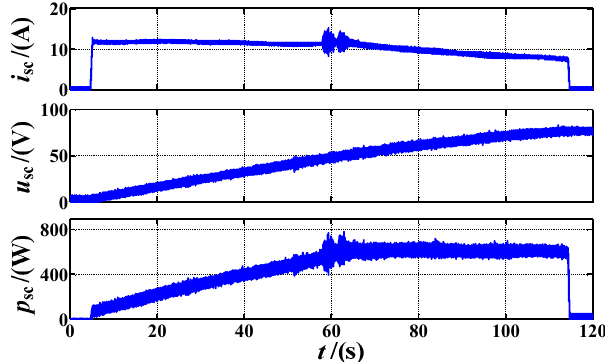
Figure 16. Voltage, current and power of supercapacitor.